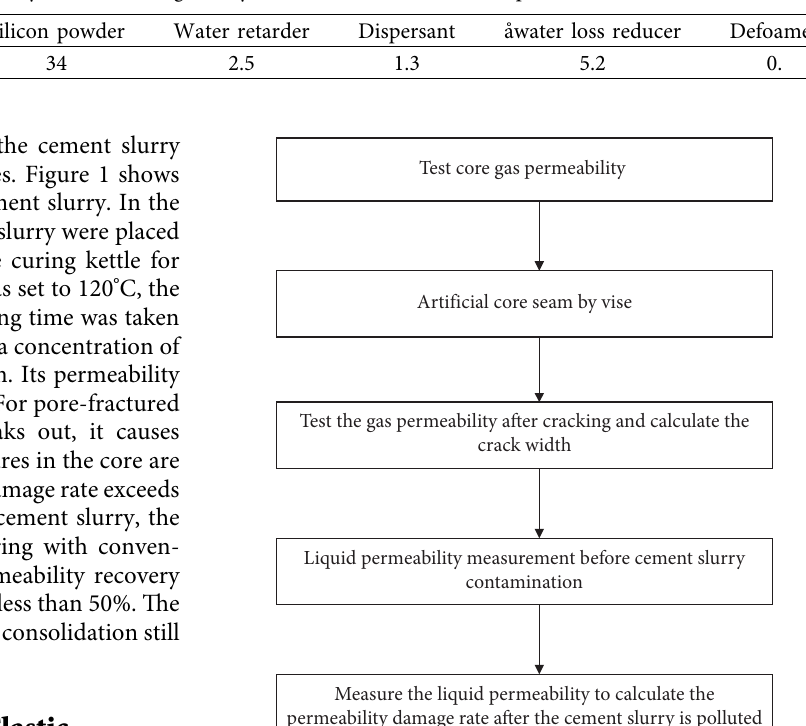
Table 3: Cement slurry formula with green synthesis and metal oxide composites.